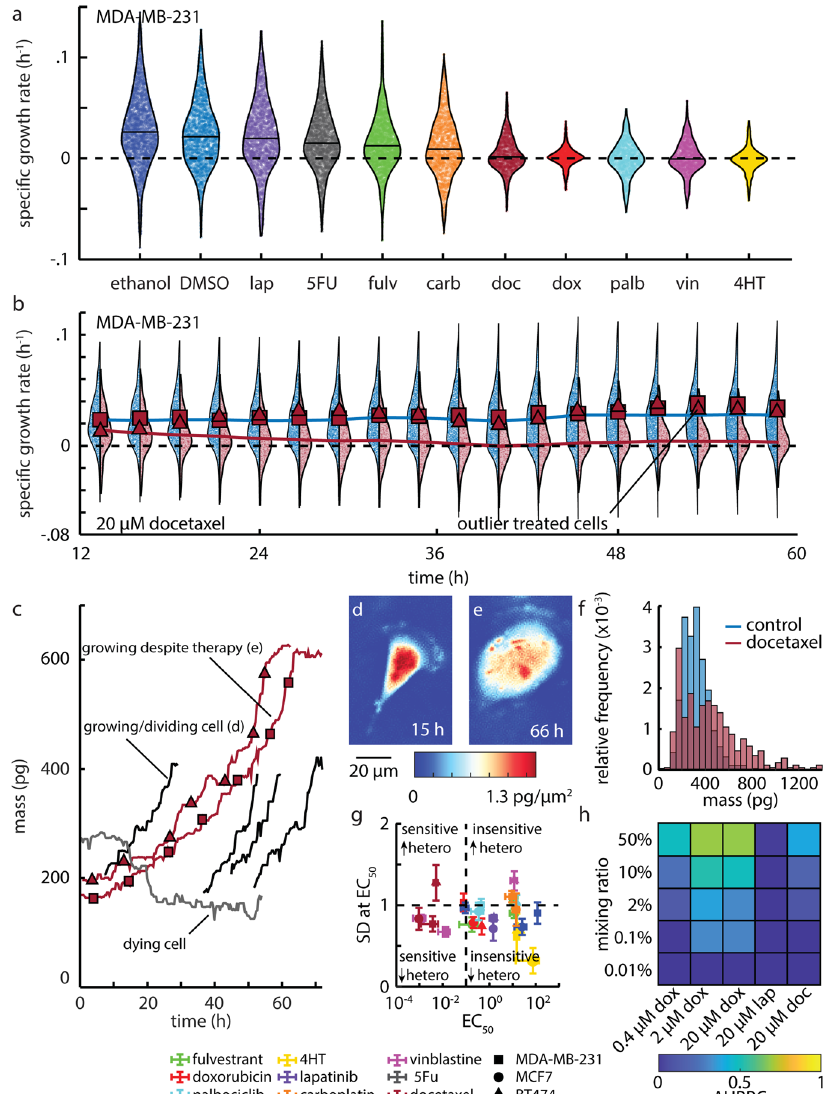
Fig. 4 QPI measures growth heterogeneity in healthy and drug-treated populations. a Growth rate distribution of 21,791 MDA-MB-231 cells at the end of 72 h of 20 µ M of the indicated drug exposure. Individual cell data are plotted and bound by the kernel density function of the distribution (black outline). Mean population response is shown as a horizontal line. Dashed line shows a growth rate of zero. b MDA-MB-231 population growth rate distributions throughout during 72 h treatment with DMSO (blue, n = 1954 cells) and 20 µ M docetaxel (maroon, n = 1071 cells). Two cells, with growth rates greater than mean of control (growth rate shown as square and triangle) at the end of experiment are traced back in time to determine how their growth rate evolved throughout the experiment. Dashed line shows a growth rate of zero. c Mass versus time tracks for these two indicated cells demonstrates that these cells grew robustly throughout the experiment despite the high concentration of docetaxel. A dying cell from this experiment (gray) and normally growing cells from DMSO control (black) are also shown. d Control cell from panel c indicating normal cell size and appearance. e Aberrantly large cell from panel c persisting in the presence of 20 µ M docetaxel. f Histogram showing the fi nal mass for docetaxel treated cells (red, n = 343 cells) as well as for DMSO treated cells (blue, n = 563). g Standard deviation at EC 50 plotted against EC 50 for cell growth. Points below horizontal dashed line (24 h) represent fast responders, vertical dashed line divides sensitivity from insensitivity of a cell line to a particular therapy. Error bars show SEM. Heterogeneity is abbreviated as hetero. h Normalized area under precision-recall curve (AUPRC) plotted against the % control cells mixed into the drug-treated